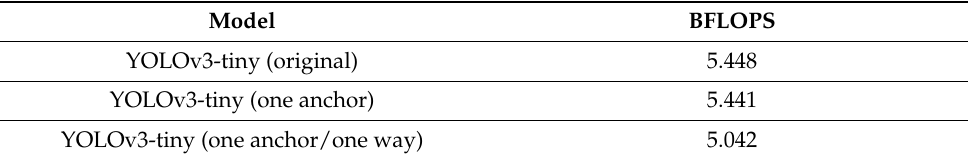
Table 7. Comparisons of computational complexities among the three YOLO-based models.